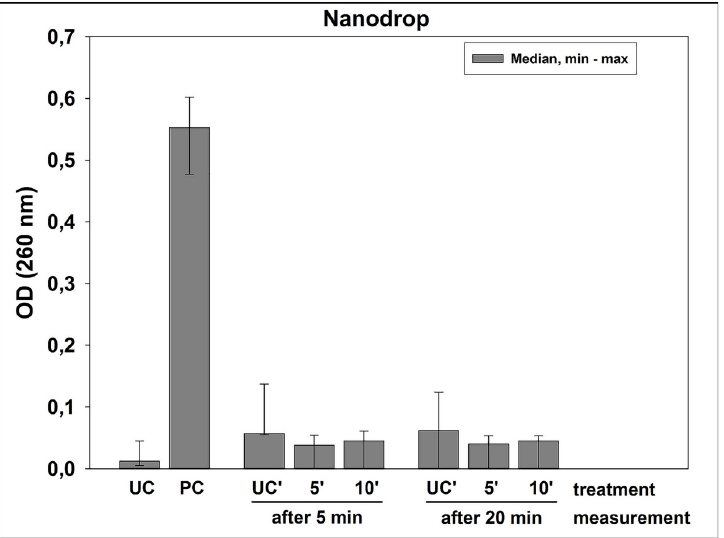
Fig 5. Spectroscopic measurements for release of nucleic acids upon CAP treatment. OD medians, minima and maxima of the supernatants of untreated biofilms (UC) or biofilms treated with positive control (lysozyme treatment followed by Proteinase K digestion, (PC)) or CAP, as measured at 260 nm for release of nucleic acids. For CAP, samples were measured either 5 or 20 min after being treated with CAP for 5 or 10 min or left untreated (UC’). n =